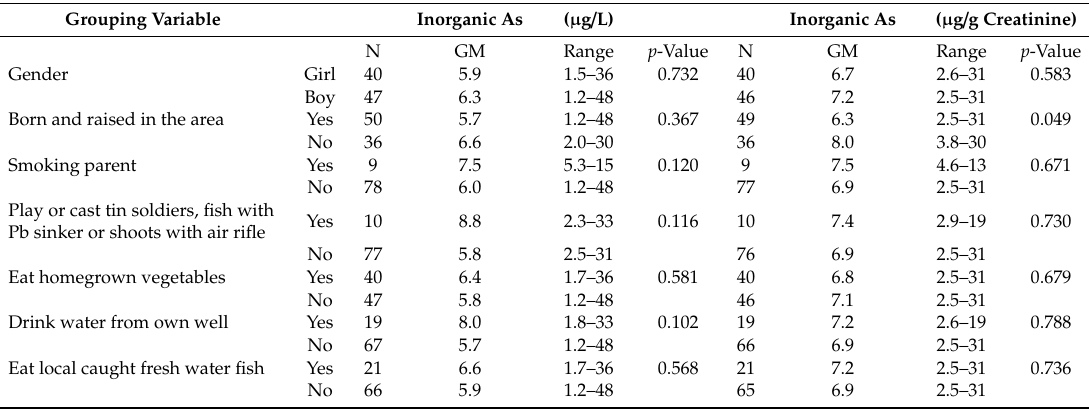
Table 5. Geometric mean values in urine for di ff erent groups of the study population. Independent t-tests have been performed between the groups to test for statistical di ff erences. Grouping